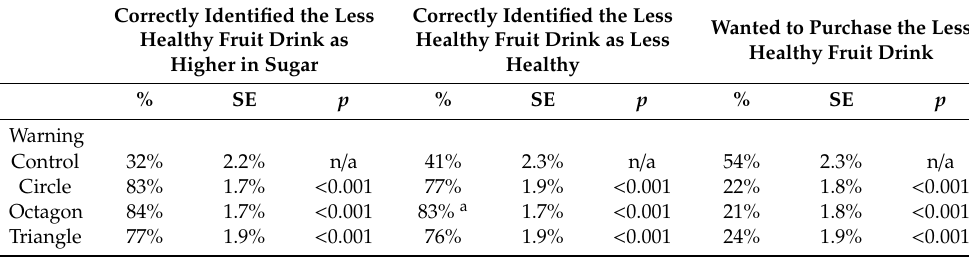
Table A5. Predicted percent identifying less healthy fruit drink as having higher sugar, selecting less healthy fruit drink as being unhealthier, and wanting to purchase the less healthy fruit drink. Correctly Identified the Less Healthy Fruit Drink as